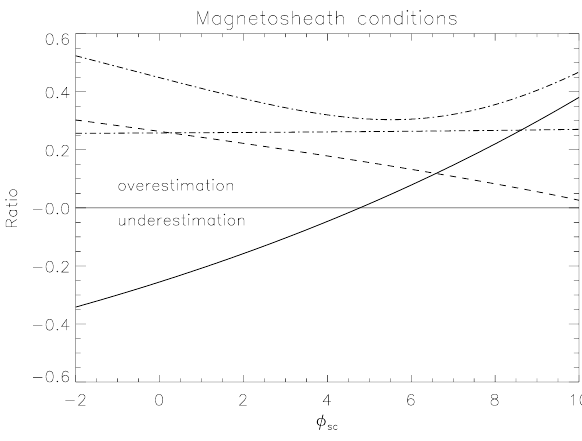
Fig. 4. Estimation ratios as in Fig. 3 but for the magnetosheath case: r N (solid line), r v (dashed line), r T (dot-dashed line). The upper curve is the estimation index I e .